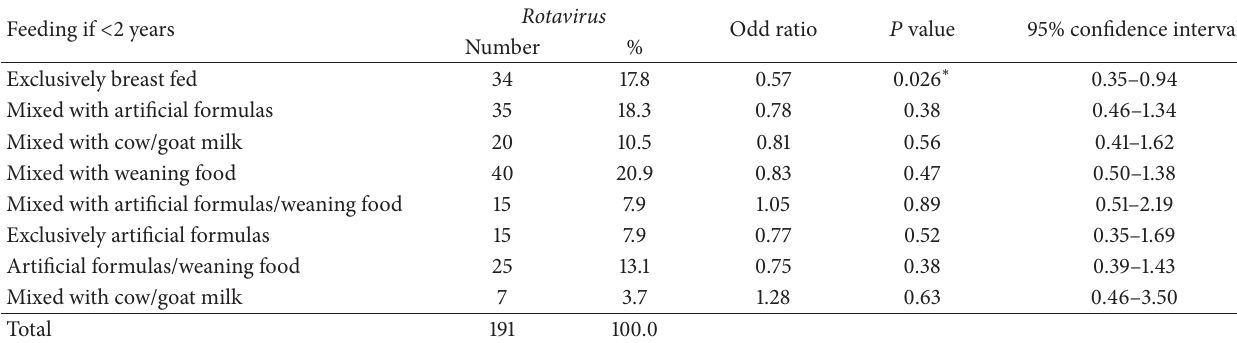
Table 6: Effect of feeding on outcome of Rotavirus diarrhea among children in Taiz, Yemen (𝑛 = 385) .